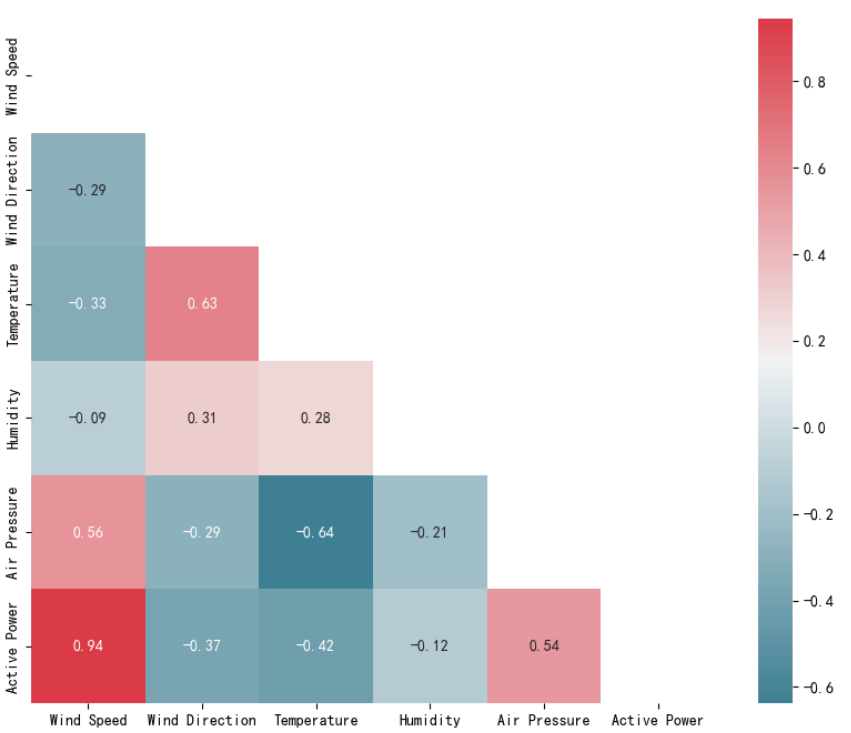
Figure 5. Heat map of feature correlation.